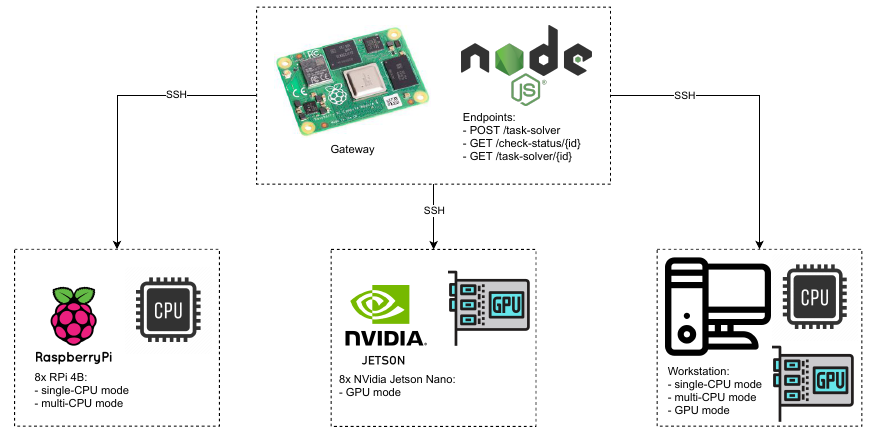
Figure 4. Computational edge system